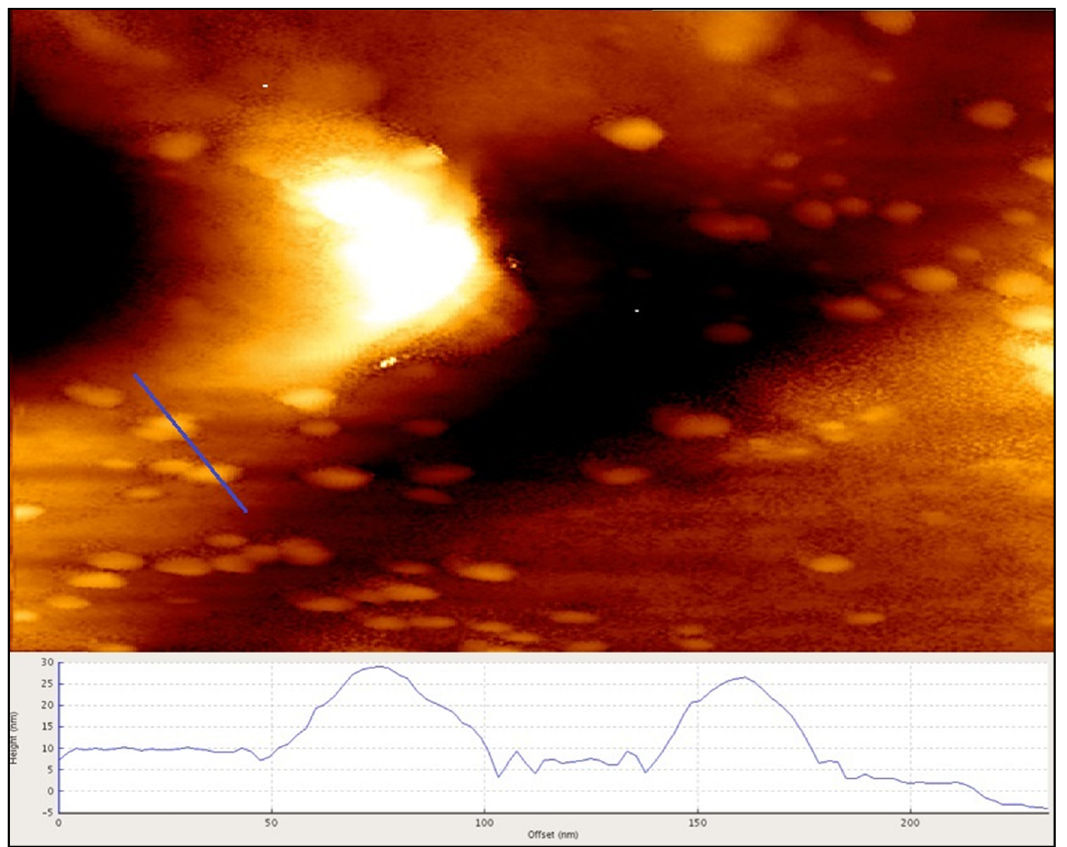
Figure 3: AFM image ( top ) and height pro fi le ( bottom ) of the PMMA – 15 wt% MXenes with an inset blue dotted line crossing a few MXene layers.